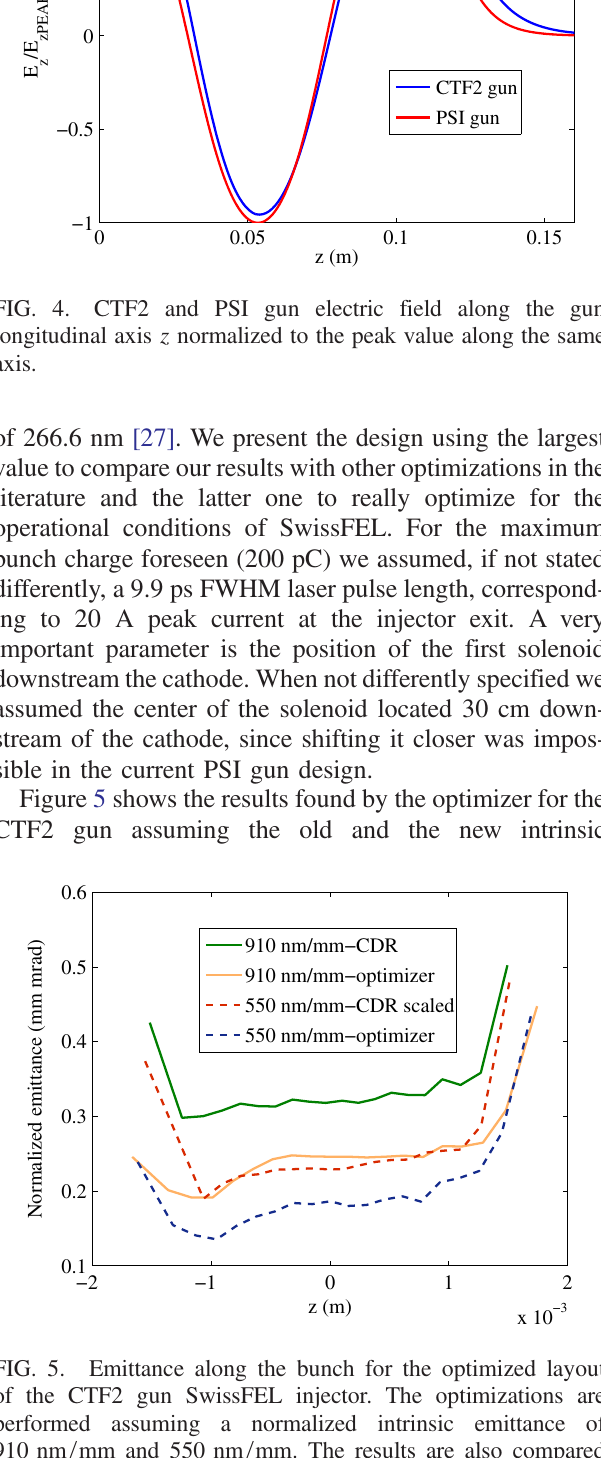
FIG. 6. Emittance along the bunch for the optimized layout of the PSI gun SwissFEL injector. The optimizations are performed assuming a normalized intrinsic emittance of 910 nm = mm and 550 nm =